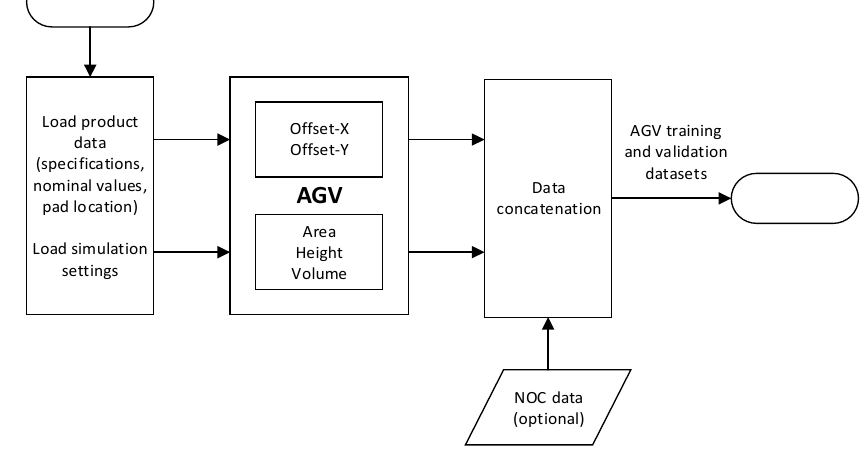
Figure 2. Schematic representation of the AGV module.